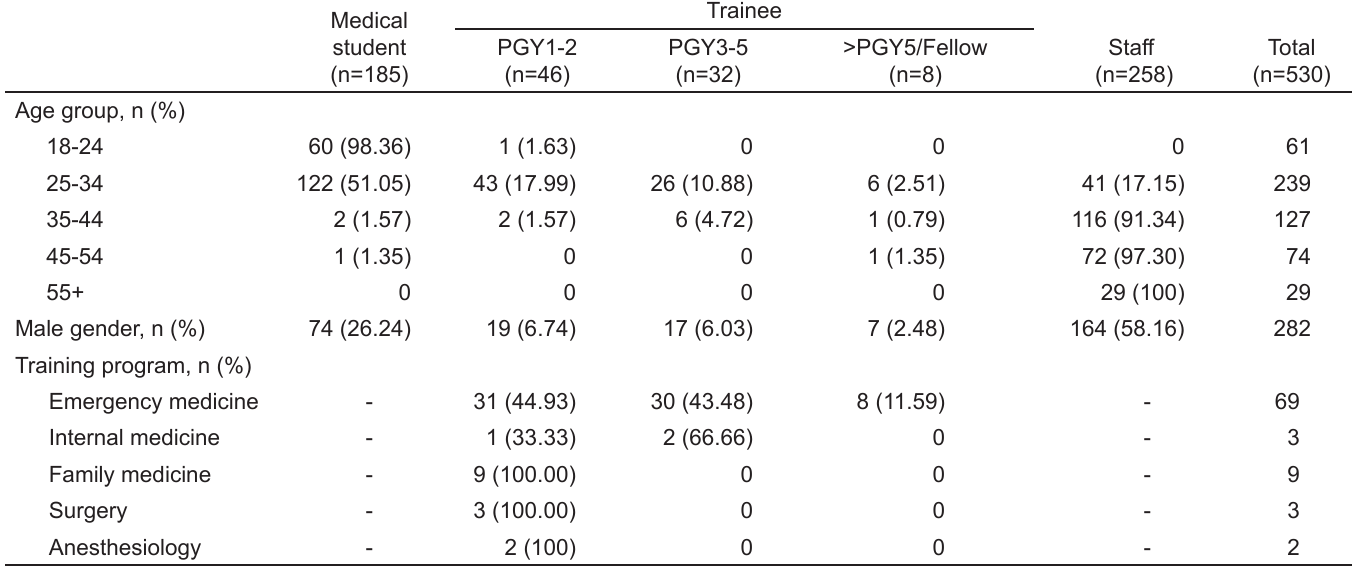
Table 1. Demographics of survey